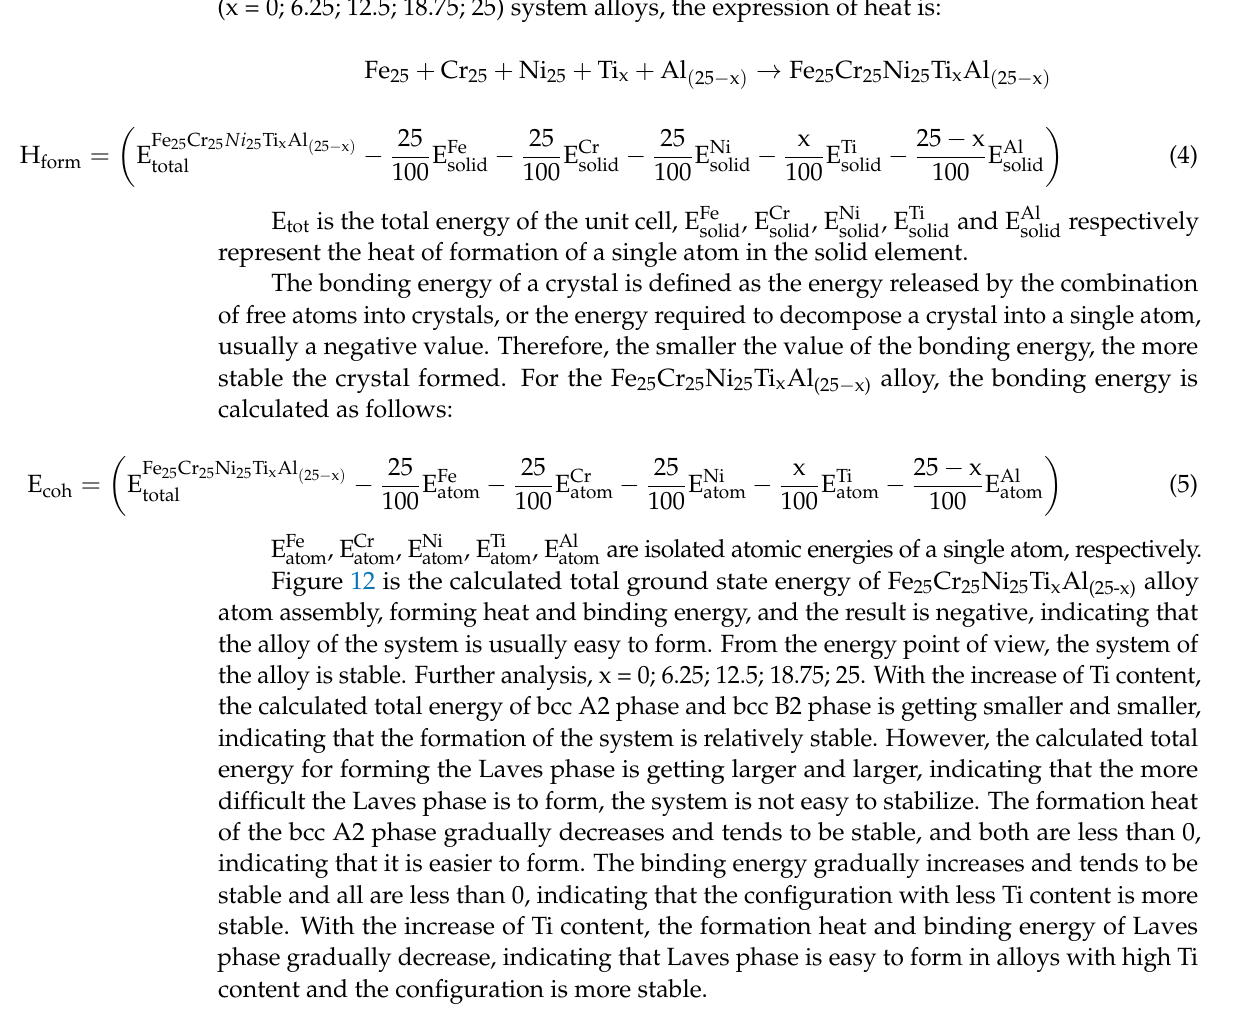
, E Cr , E Ni , E Ti and E Al respectively solid solid solid solid solid